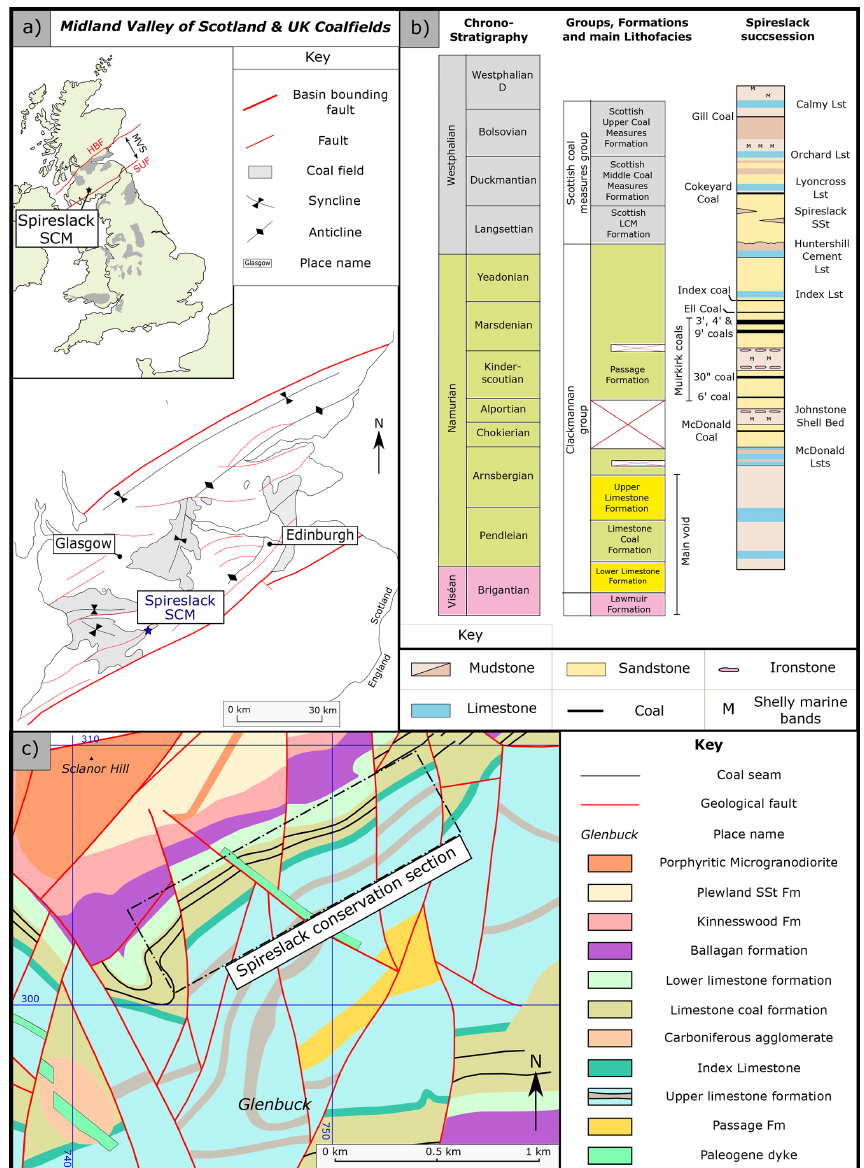
Figure 1. (a) Map of UK coalfields (adapted from Donnelly, 2006) showing the location of Spireslack Surface Coal Mine (SCM) and structural features of the Midland Valley of Scotland. (b) Regional geology and (c) stratigraphy of Spireslack Surface Coal Mine (following Ellen et al.,